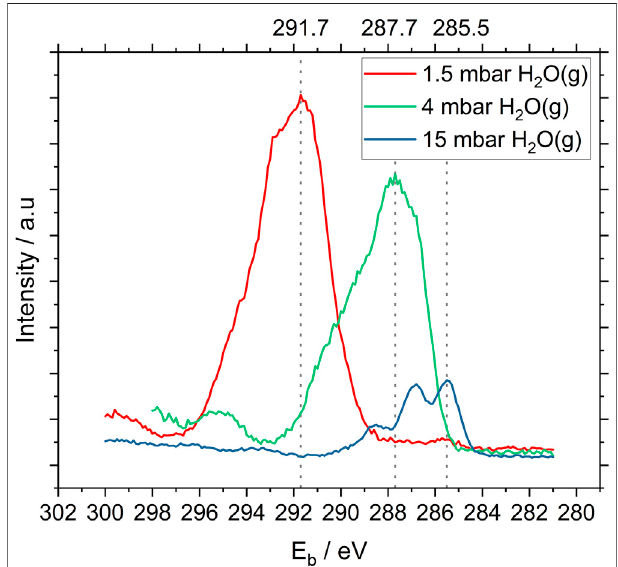
FIGURE 2 | High resolution C1s NAP-XP -spectra of P. fl uorescens acquired under different (increasing) pressures of water vapor in the analysis chamber of the instrument. Count rate maxima are indicated by the stippled lines. Note that these spectra are not corrected for surface